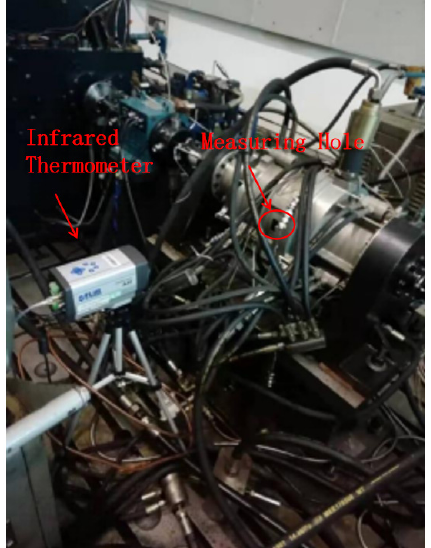
Figure 3. Layout drawing of the clutch comprehensive test table.